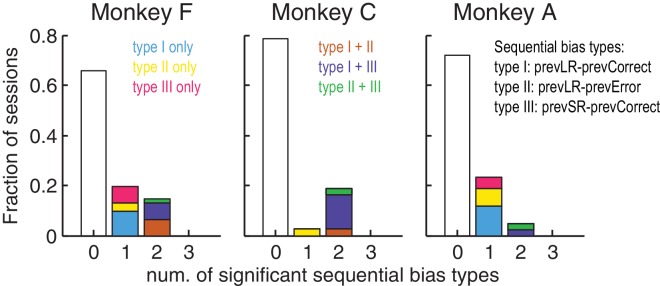
Monkeys showed minimal sequential choice biases.Histogram of the fraction of sessions with 0, 1 or 2 types of sequential choice biases. Colors indicate the sequential bias types with respect to the previous reward (Large or Small) and outcome (Correct or Error), as indicated. Significant sequential bias effects were identified by a likelihood-ratio test for H0: the sequential term in the logistic regression = 0, p<0.05.